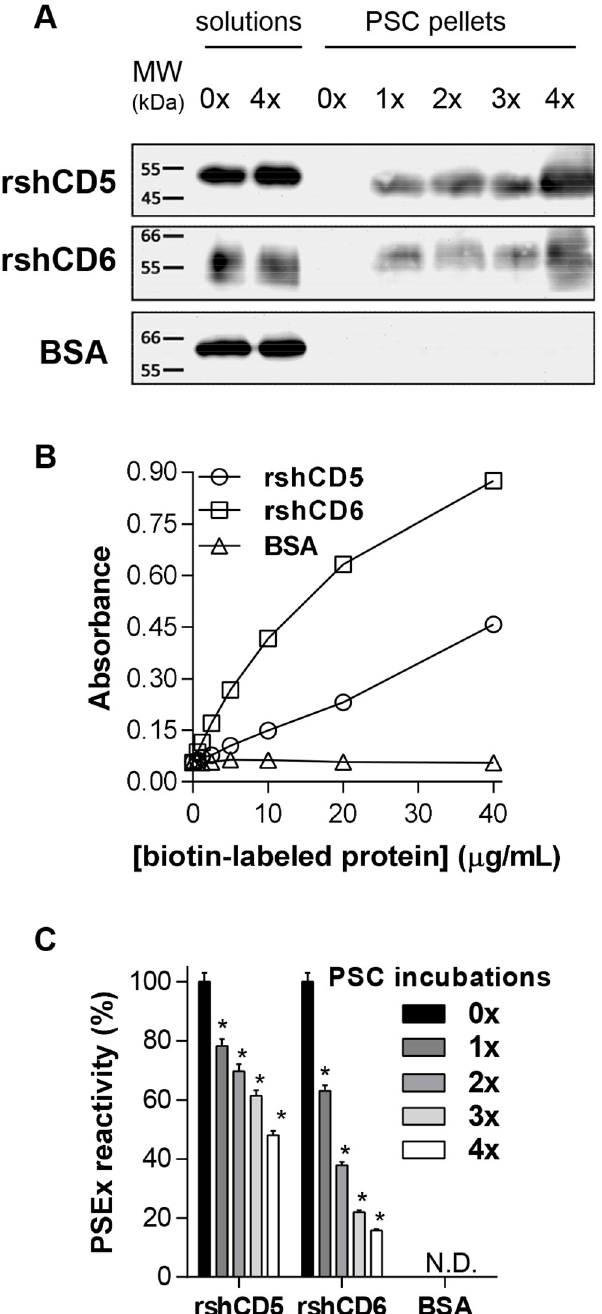
Fig 1. CD5 and CD6 ectodomains bind PSC tegumental antigens. ( A ) Biotin-labeled rshCD5, rshCD6 and BSA protein solutions (20 μ g/mL) were sequentially incubated (4 times) with PSC suspensions (5,000 PSC; viability � 90%), and pellets and solutions run on SDS-PAGE and further Western blotted with HRP-streptavidin. Lanes 1 and 2: protein solutions before (0x) and after 4 sequential incubations with PSC (4x), respectively. Lanes 3 to 7: PSC pellets after 0x to 4x sequential incubations. ( B ) ELISA assays showing the binding of increasing amounts of biotinylated rshCD5, rshCD6 and BSA proteins to PSEx-coated plates. ( C ) ELISA assays showing the binding of supernatants from sequential PSC incubations of biotin-labeled rshCD5, rshCD6 and BSA depicted in ( A ), to PSEx-coated plates. N.D. not detected. ( � ) Significant differences (Student’s t-test, P < 0.05) respect to 0x results.